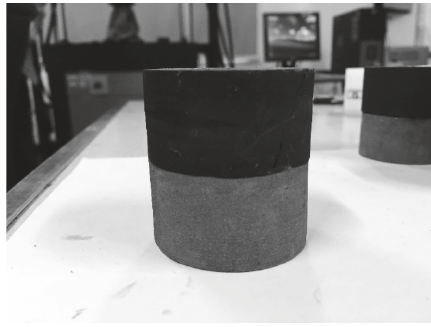
Figure 1: Specimen photograph of coal-rock combined body.